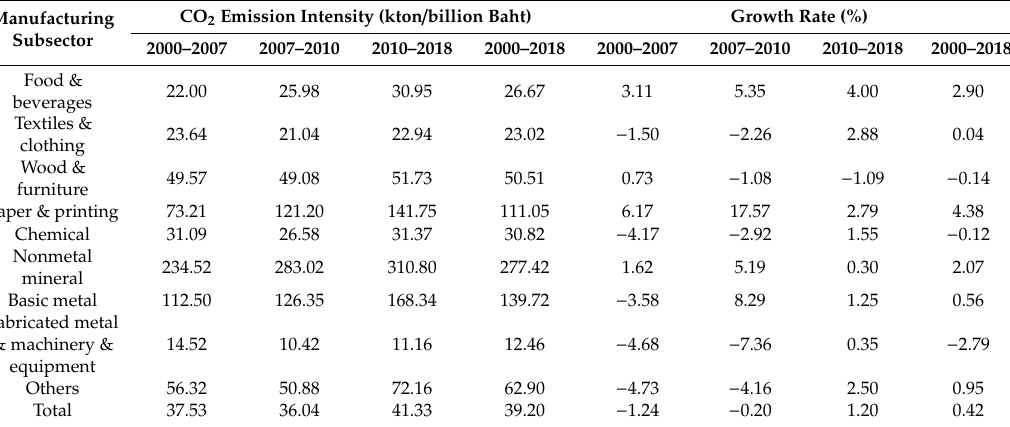
Table 10. Amount and annual rate of change of CO 2 emission intensity of manufacturing industry by